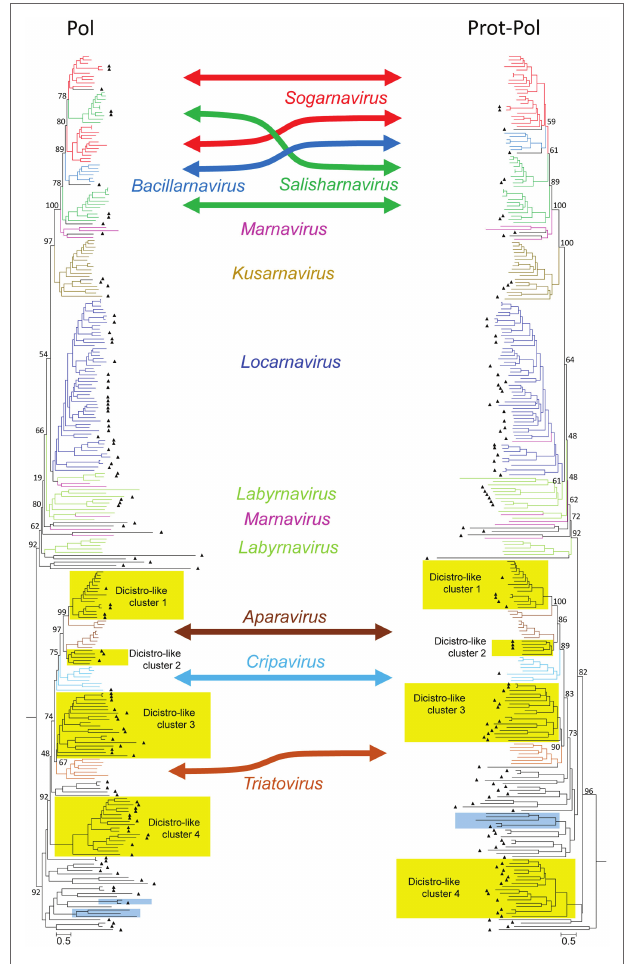
FIGURE 1 | Phylogenetic analysis of 267 polymerase- (left) and 264 proteinase/polymerase-encoding sequences (right) of dicistroviruses, marnaviruses, and unassigned viruses. Sequences were aligned with MEGA and manually adjusted. The trees were inferred with IQ-Tree 2, optimal substitution model: GTR + F + R9 for the pol tree and GTR + F + R10 for the prot/pol tree, respectively. Numbers at nodes present bootstrap values obtained after 50,000 ultrafast bootstrap replications. The scale indicates substitutions per site. The respective genera are indicated. Color codes: aparaviruses, dark brown; bacillarnaviruses, blue; cripaviruses, light blue; kusarnaviruses, ochre; labyrnaviruses, light green; locarnaviruses, dark blue; marnaviruses, magenta; salisharnaviruses, dark green; sogarnaviruses, red; triatoviruses, brown; and untypeable viruses, black. A triangle ( ▲ ) indicates viruses identified in the present study. Blue boxes indicate viruses with unusual genome layout (capsid protein-encoding gene region at the 5 ′ -end; nonstructural polyprotein-encoding gene region at the 3 ′ -end). Yellow boxes indicate four dicistrovirus-like sequence clusters. More details of this figure are presented in Supplementary Figure 1